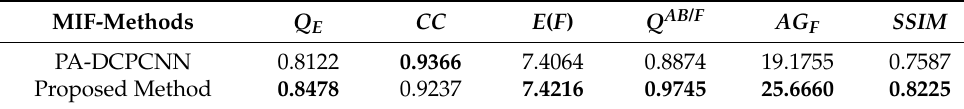
Figure 14. Multi-focus image of a leaf from various perspectives. Original Image: ( a ), Multi-focus Input Images: ( b , c ), and Proposed Fusion: ( d ). Table 8. The results and comparisons for leaf image ([20]).